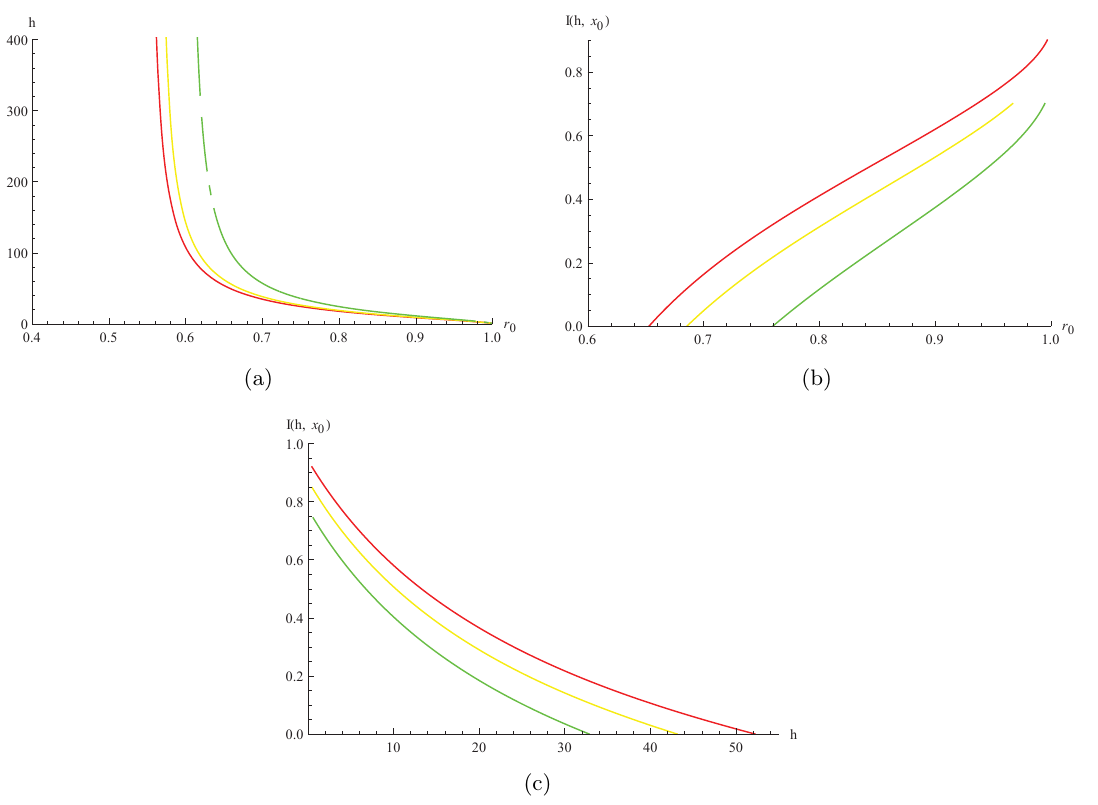
Figure 8 . Panel (a): the relation between the shift h and the minimal radius r 0 for various m ; panel (b): the relation between the mutual information I ( h; x 0 ) and r 0 for various m ; panel (c): the relation between I ( h; x 0 ) and h for di(cid:11)erent m . In numerics we have set (cid:22) r = 0 : 2, r min = 50, Q = 0 : 5, r h = 1. The red, yellow and green lines correspond to m = 0 : 2 ; 0 : 3 ; 0 : 4